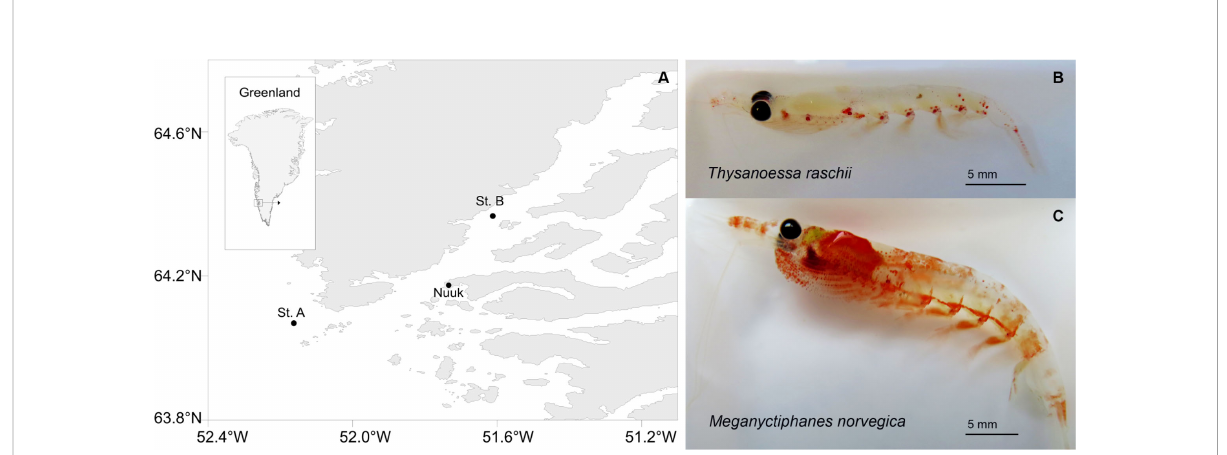
FIGURE 1 Study site and krill species. (A) Nuup Kangerlua fjord in Southwest Greenland. Black circles indicate the 2 sampling stations where krill was collected. (B) Thysanoessa raschii collected at the station (St.) A. (C) Meganyctiphanes norvegica collected at St.